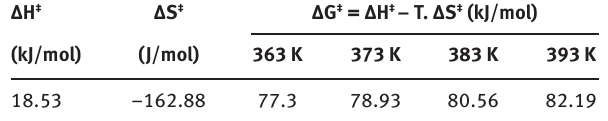
catalysed by ZnBr /TBAB. 2 2